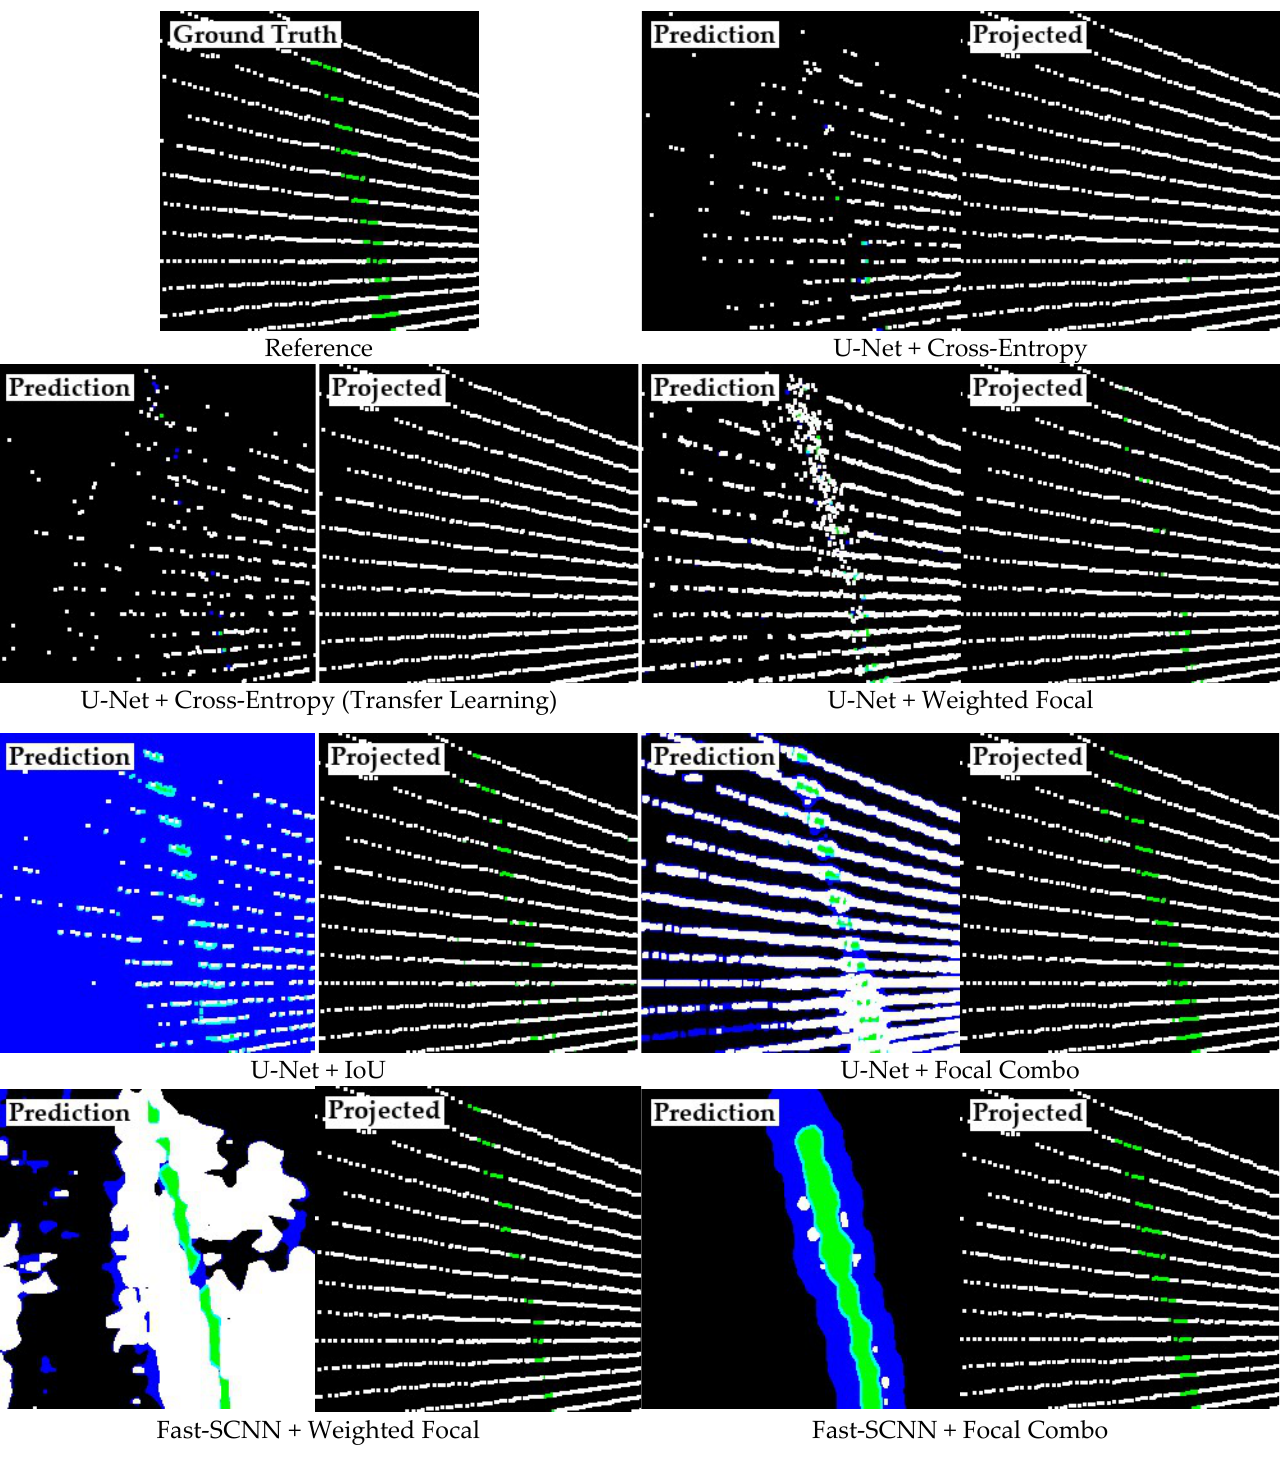
Figure 11. Sample prediction results using existing methods in road markings and their projected counterparts. Table 8. Results in comparison to existing methods in (%) for the road marking class.